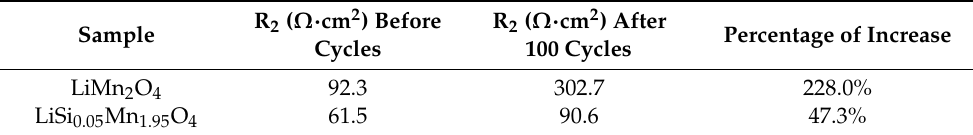
Table 2. Fitting values of the charge transfer resistance (R 2 ) calculated from